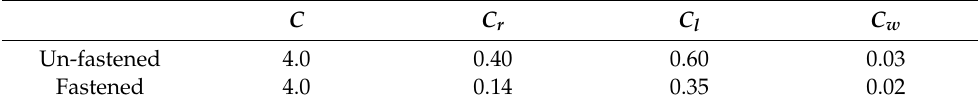
Table 1. Coefficients for fastened and un-fastened channels under EOF load case [10].